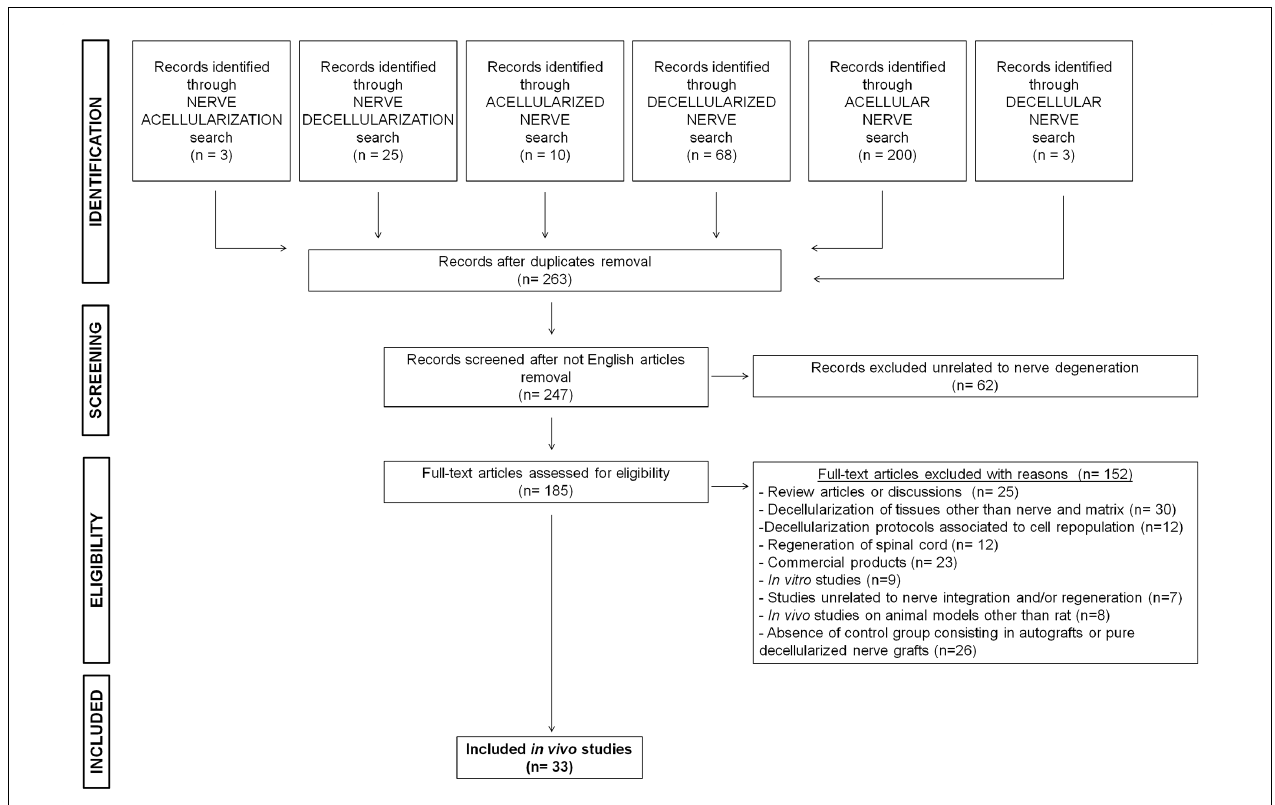
FIGURE 1 | Research strategy. Flow chart of the selection